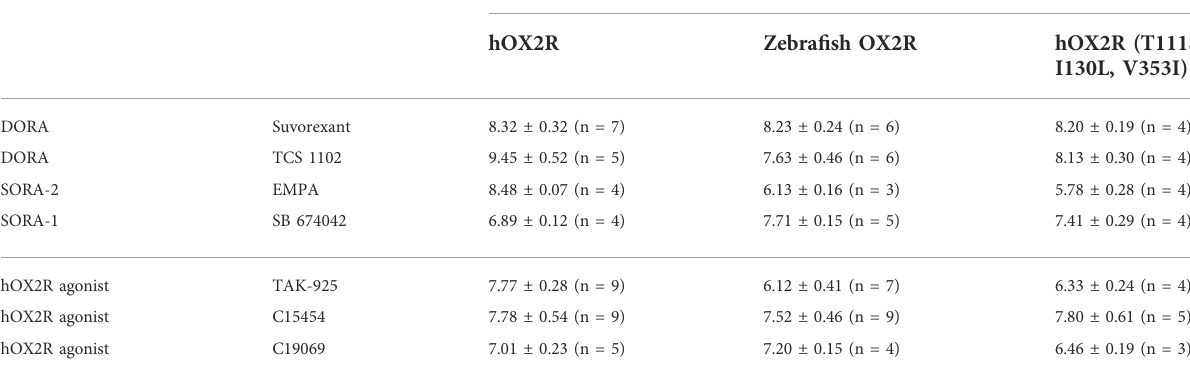
TABLE 1 Evaluation of antagonists and agonists on human OX2R, zebra fi sh OX2R and human OX2R bearing zebra fi sh pocket mutations in an IP-One functionalassay.Antagonist potency is represented as the negativelog of the molar antagonist concentration for which 50% of receptors will be occupied (pKi), agonist potency as the negative log of the molar agonist concentration for which 50% of the maximum stimulation is observed (pEC50). Data are averages of at least 3 independent repeats with the exception of EMPA and